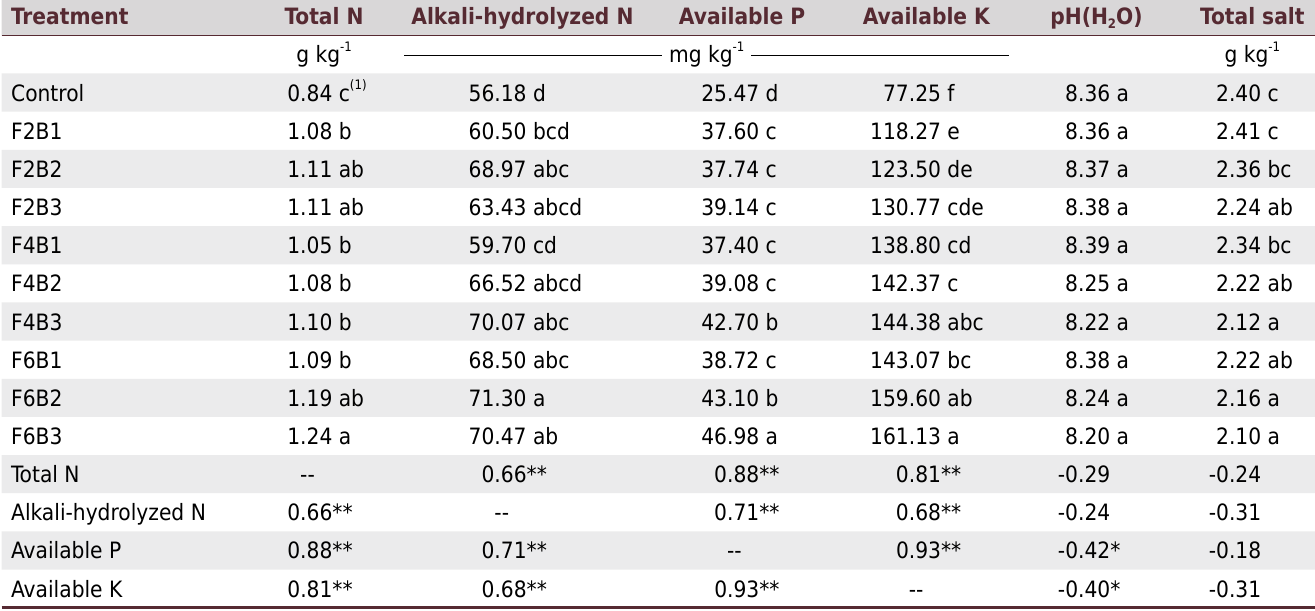
Table 2. Soil chemical properties and correlation analysis Treatment Total N Alkali-hydrolyzed N Available